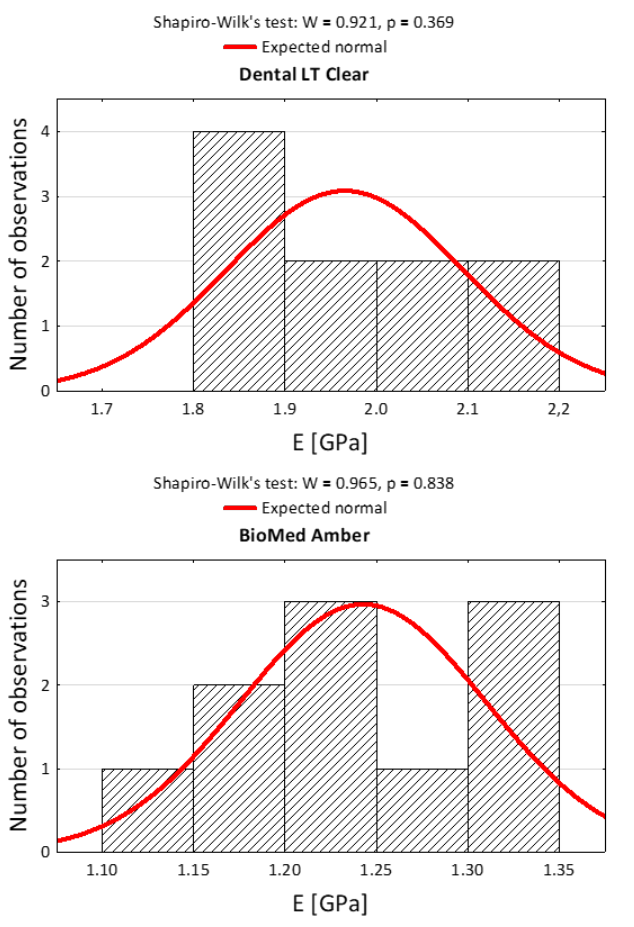
Figure 4. Histograms of the results of the measurement of Young’s modulus in tensile against the background of the normal distribution for the three dental materials and the results of the normality tests. Table 2. Basic statistics of the mechanical properties of the dental materials (Dental LT Clear and BioMed